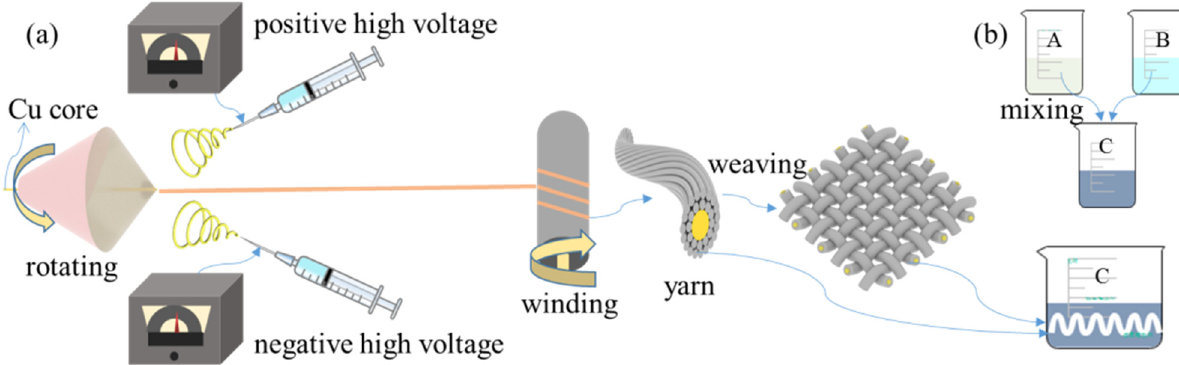
Figure 1: ( a ) Diagram of the preparation of PVDF yarn and fabric and ( b ) the preparation of PANI solution and the preparation of PANI/PVDF